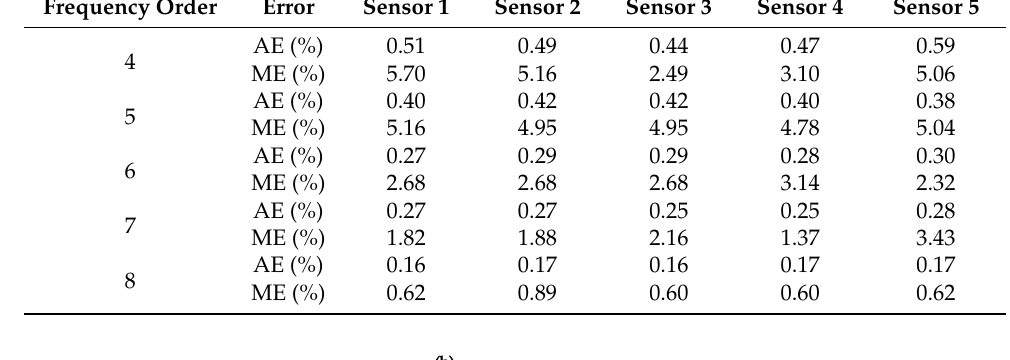
Figure 10. ( a ) Average error and ( b ) maximum error of each sensor. Table 2. Error of tension calculated by each order frequencies.